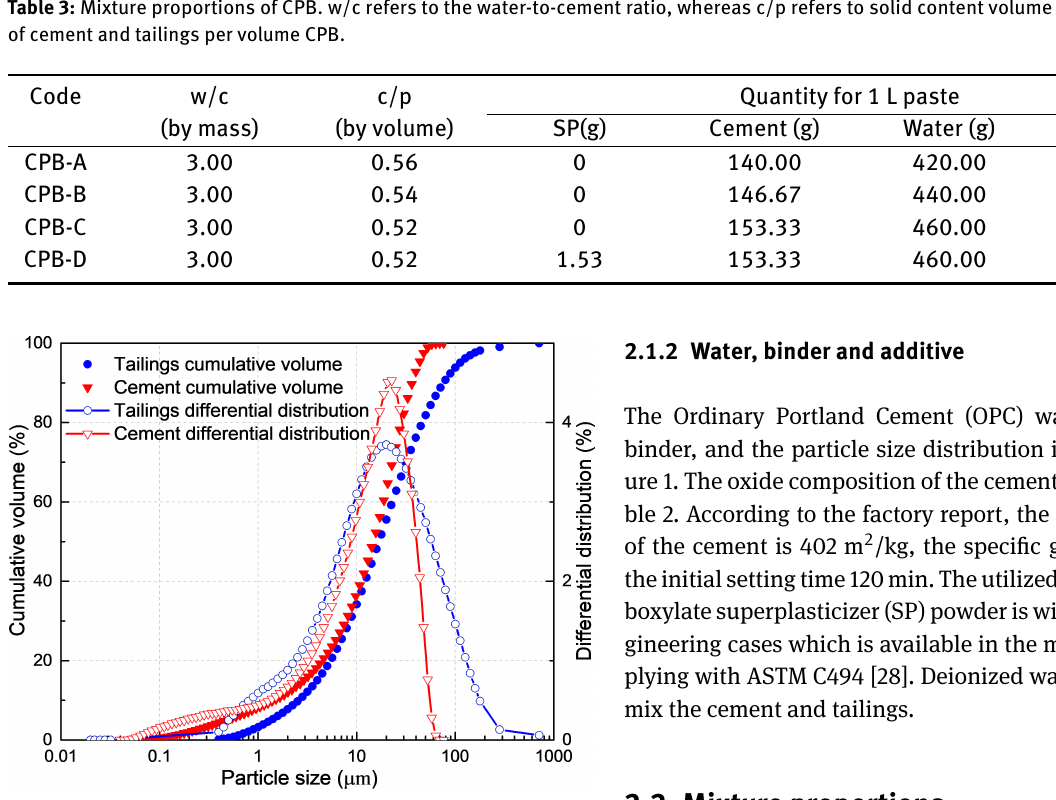
Figure 1: Particle size distribution of the unclassified tailings and